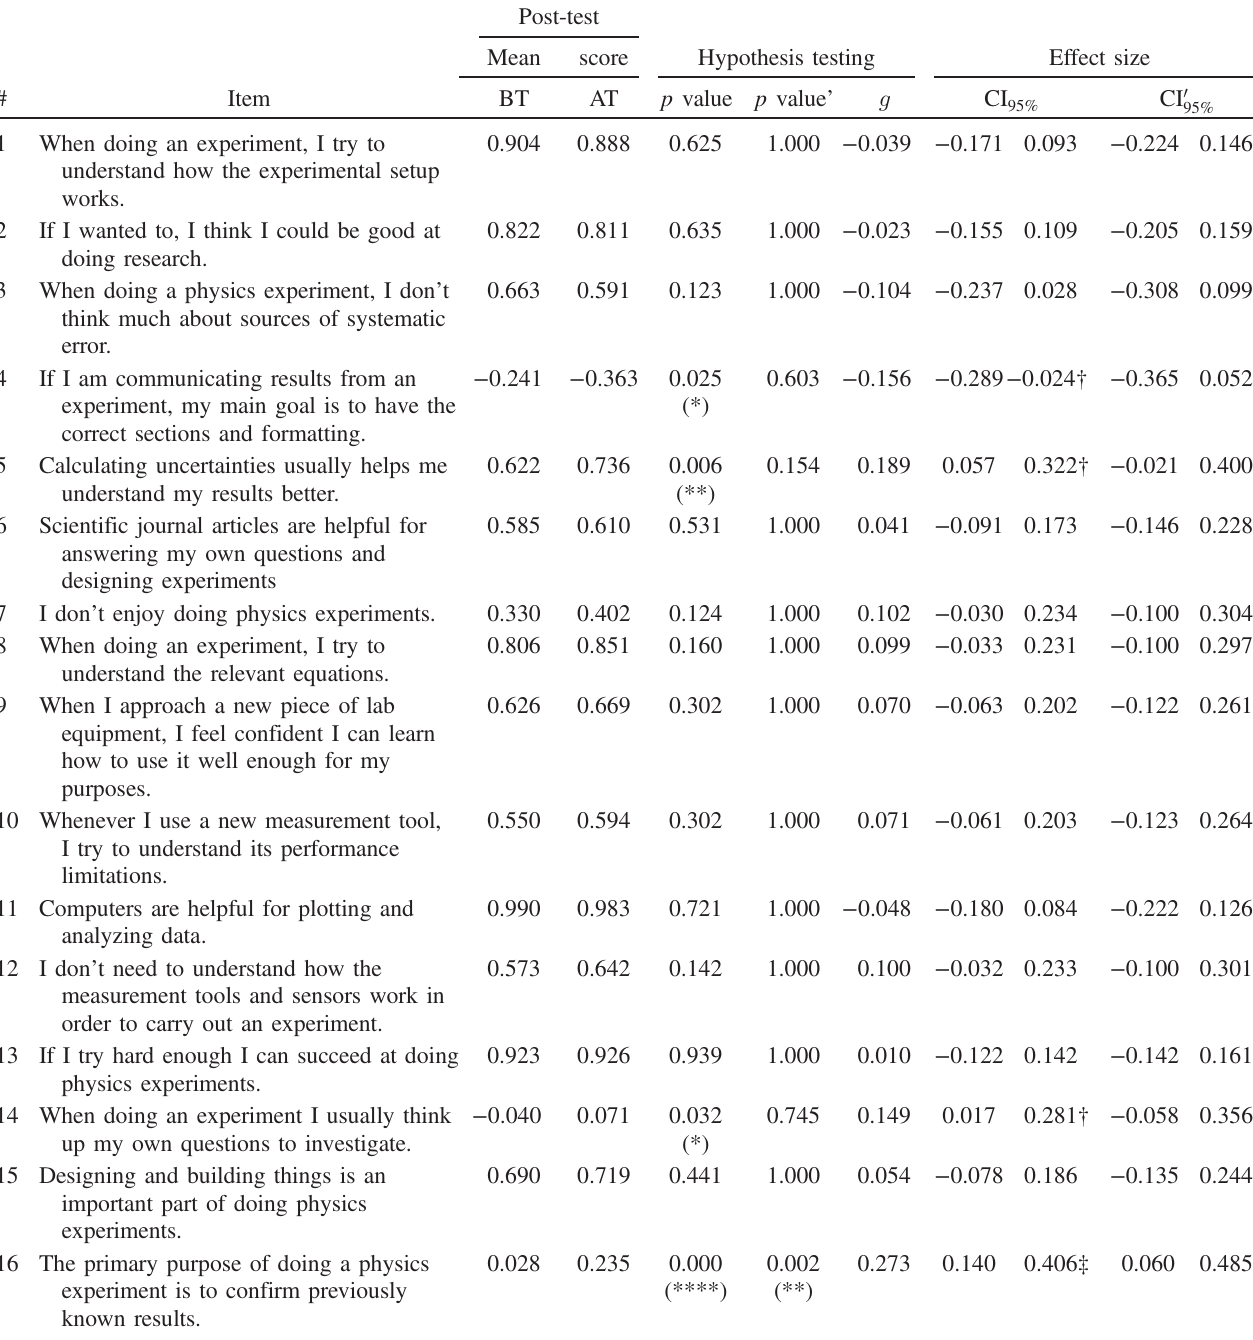
TABLE X. E-CLASS items compared between BT and AT scores for women as plotted in Figs. 3 and 4. The p values are adjusted using the Holm-Bonferonni correction and the CI 0 95% on the effect size are adjusted using the Ryan-Holm step-down Bonferroni procedure. Significance of p values are given by (*) for p ≤ 0 . 05 , (**) for p ≤ 0 . 01 , (***) for p ≤ 0 . 001 , and (****) for p ≤ 0 . 0001 . The † indicates a small, nonzero effect size ( g < 0 . 2 ) while ‡ denotes a medium, nonzero effect size ( 0 . 2 ≥ g < 0 . 8 ). There are no large effect sizes from this